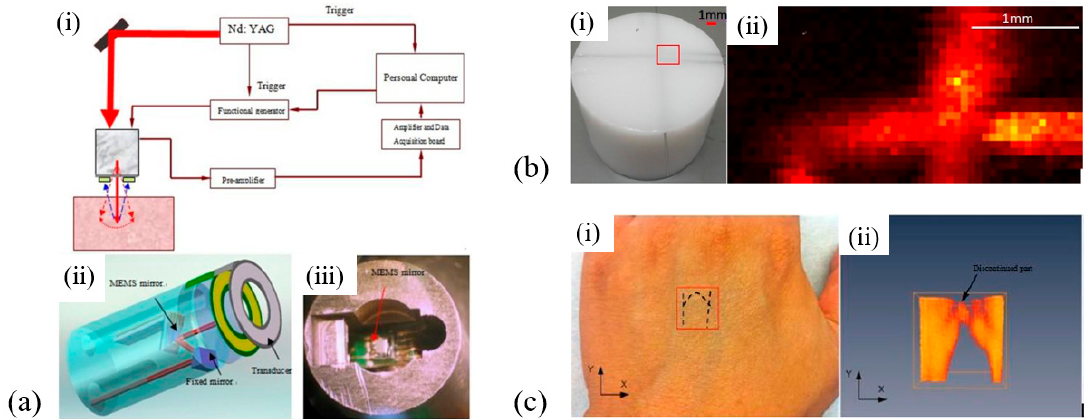
Figure 4. ( a ) Microelectromechanical systems (MEMS)-based photoacoustic probe: schematic of the system (a-i), 3D rendering (a-ii), and photograph (a-iii) of the scanning probe. ( b ) Photograph (b-i) and recovered photoacoustic image (b-ii) of the phantom. ( c ) Photograph of the hand (c-i) with a recovered 3D photoacoustic image of blood vessels (c-ii) (Reproduced with permission from OSA [60]).